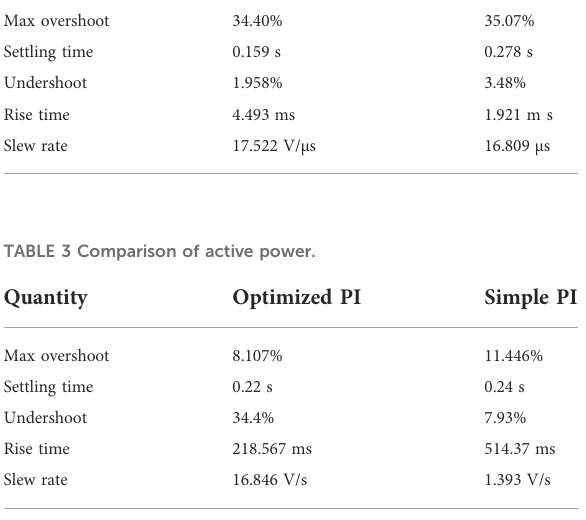
FIGURE 6 Voltage Curve for a simple PI controller.